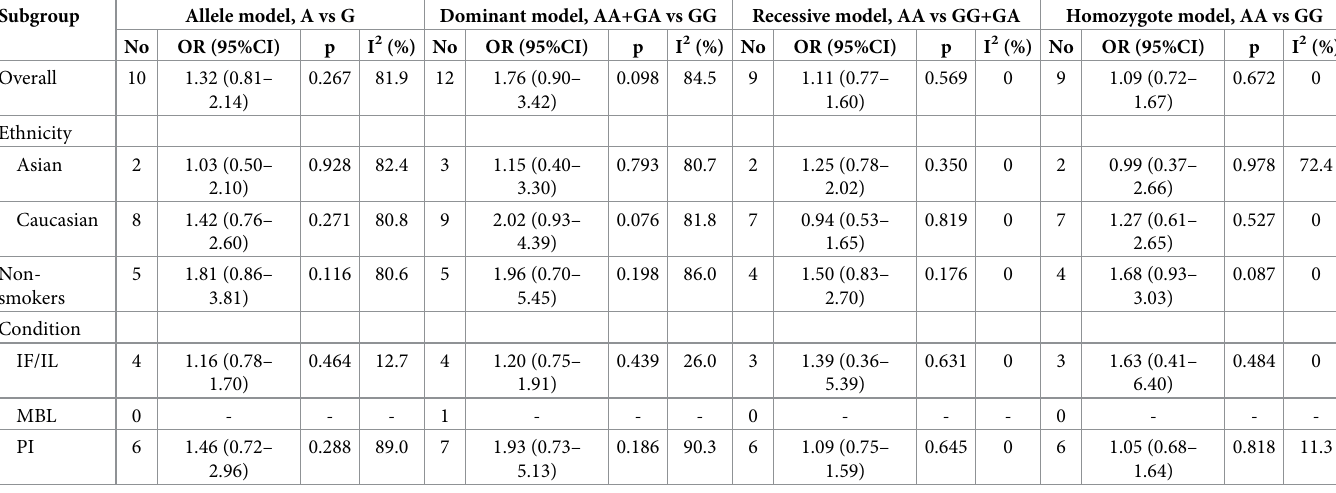
Table 5. Association between TNF α G-308A polymorphism and susceptibility to peri-implant disease. Subgroup